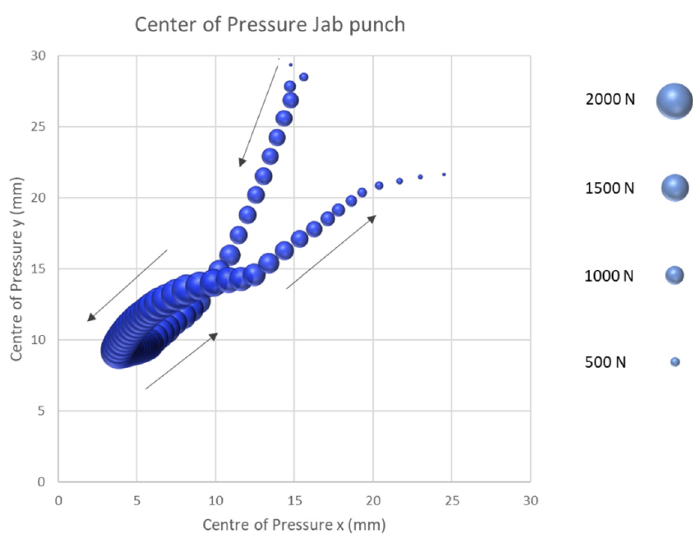
Figure 7. Centre of pressure jab punch.